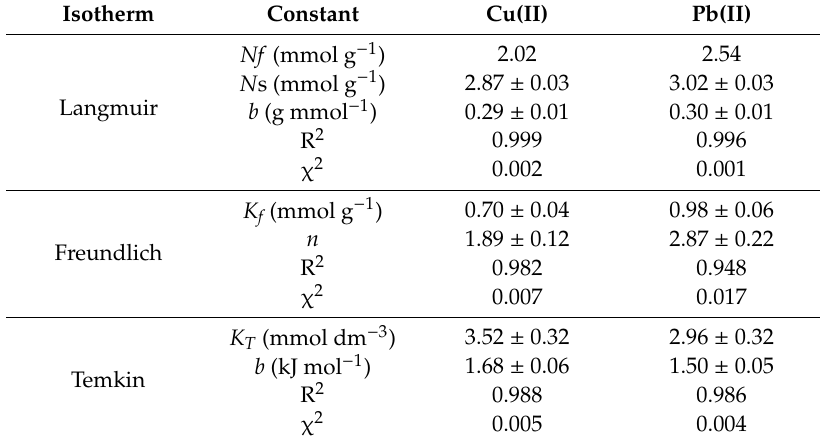
Table 4. Number of moles sorbed ( Nf ), parameters of the Freundlich ( n and K f ), Temkin ( K T and b ), correlation coe ffi cients ( r ), and respective error for the interaction of Cu 2 + and Pb 2 + with chitosan, CH-AN at 298 ± 1 K, using a nonlinear